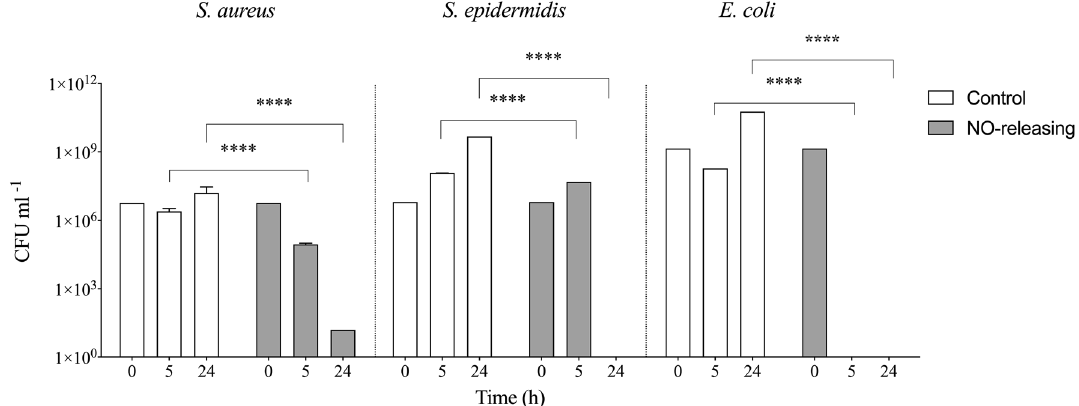
Figure 7. Bacterial viability. Bacterial growth after incubation with NO-releasing and control grafts of Gram positive strains ( S. aureus and S. epidermidis ) and the Gram negative strain ( E. coli ). The data were collected at different time points of incubation in PBS with 10% culture media. Data are shown as mean ± SD (n = 6). ****P <